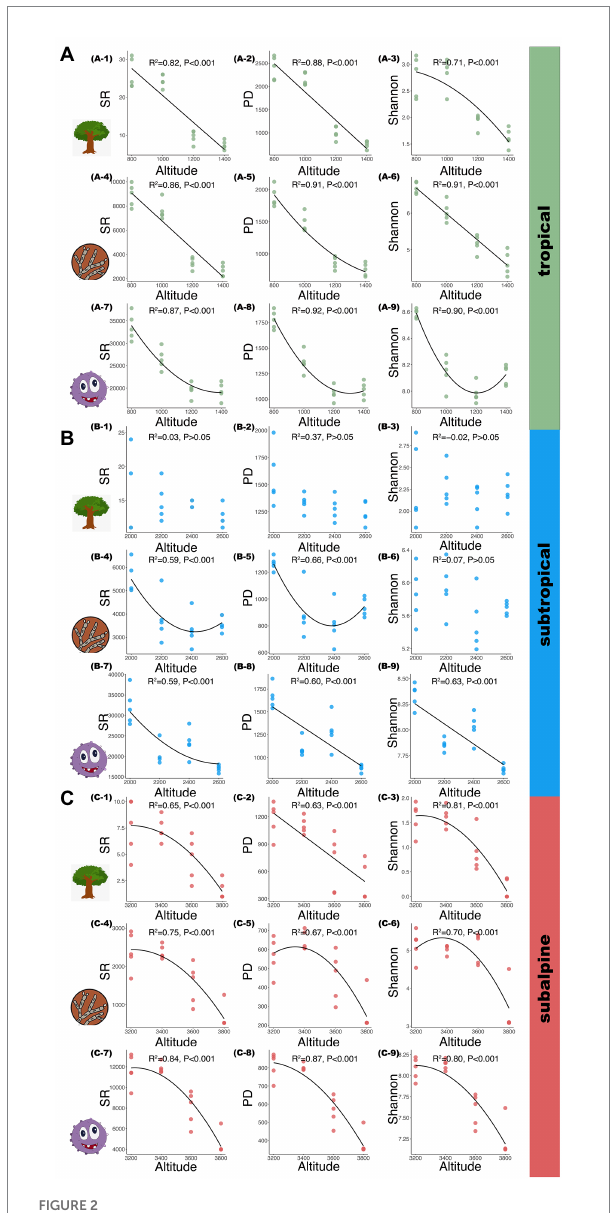
FIGURE 2 Tree, fungal, and bacterial species along elevational gradients in three climatic zones. (A) : tropical; (B) : subtropical; (C) : subalpine; A (1–3), B (1–3), C (1–3): tree species; A (4–6), B (4–6), C (4–6): fungal species; A (7–9), B (7–9), C (7–9): bacterial species. SR: species richness; PD: phylogenetic diversity; Shannon: Shannon–Wiener